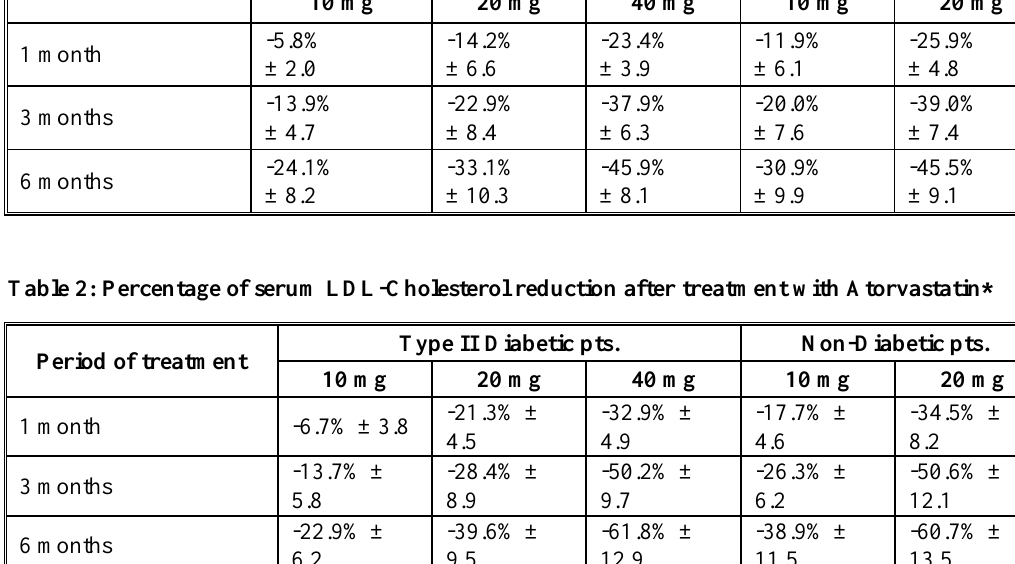
Table 1 : Percentage of serum cholesterol reduction after treatment with Atorvastatin * Type II Diabetic patients Period of treatment